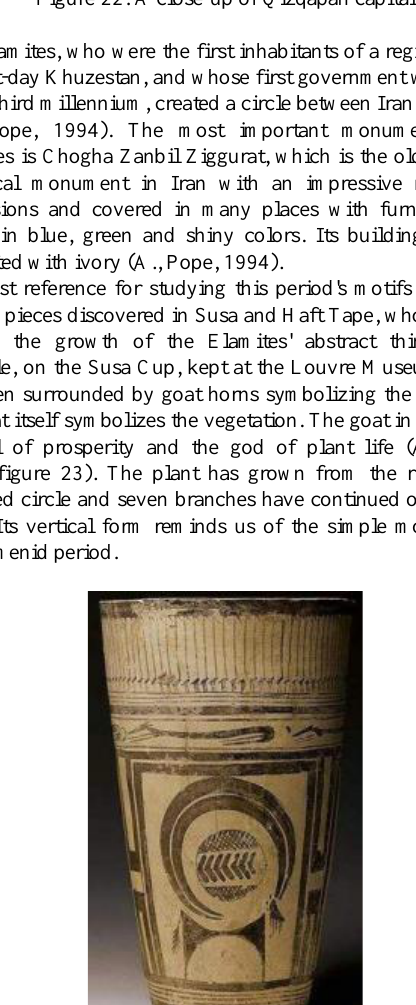
Figure 22. A close-up of Qizqapan capital